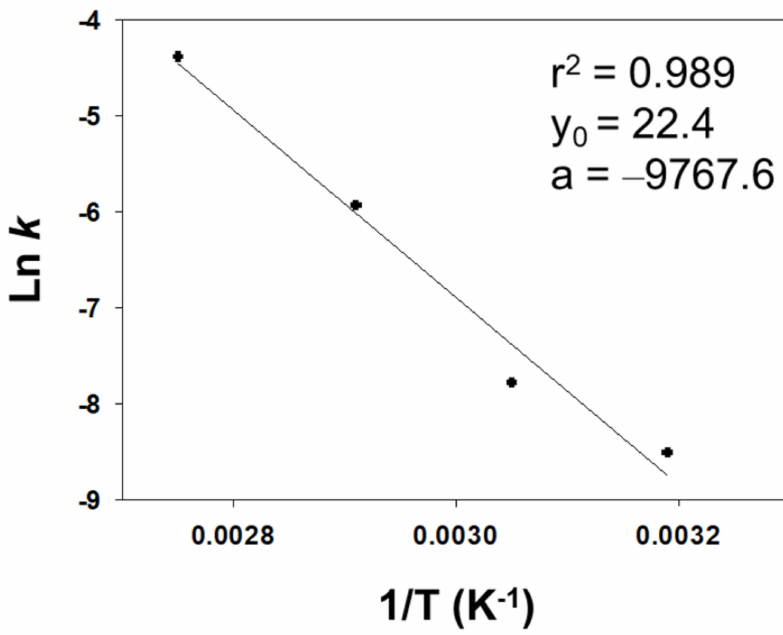
Figure 2. Arrhenius plot for the Baeyer–Villiger reaction of cyclohexanone on SiO 2